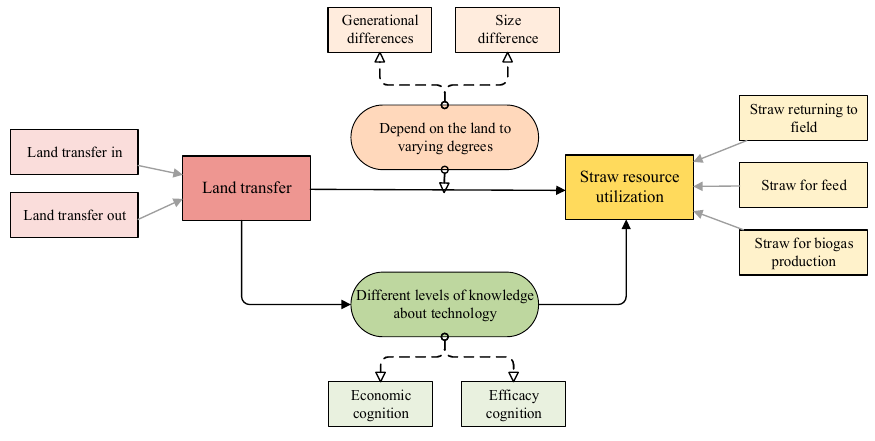
Figure 1. Theoretic analysis framework.